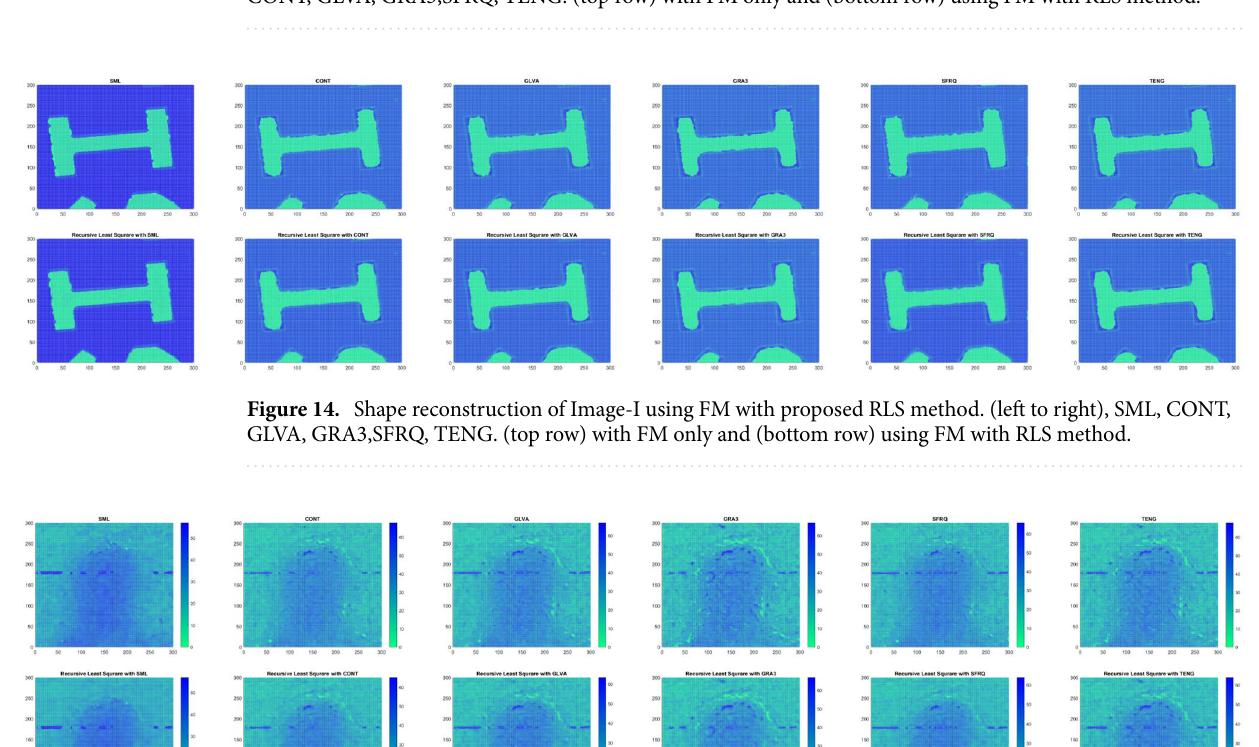
Figure 13. Shape reconstruction of LCD-TFT filter using FM with proposed RLS method. (left to right), SML, CONT, GLVA, GRA3,SFRQ, TENG. (top row) with FM only and (bottom row) using FM with RLS method.